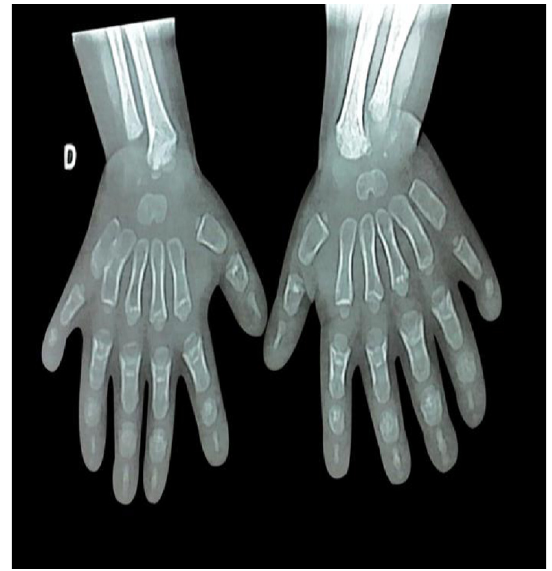
Fig. 3. X-ray of the hands showing postaxial